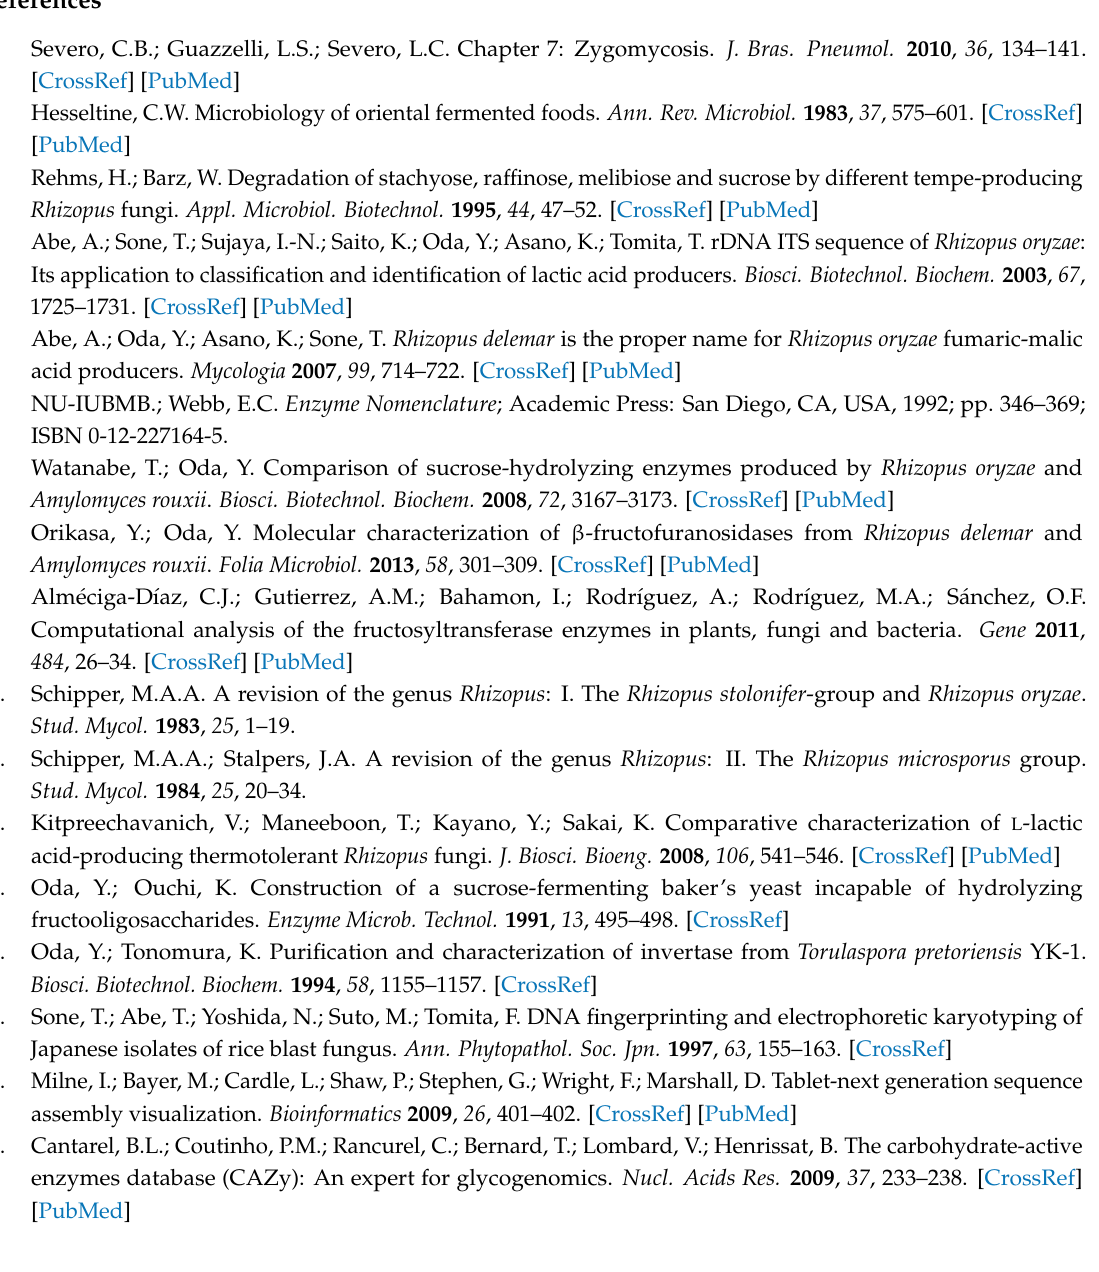
Figure S1: The full-length open reading frame (ORF) sequence of the sucA gene in R. microsporus NBRC 32995 (accession number: